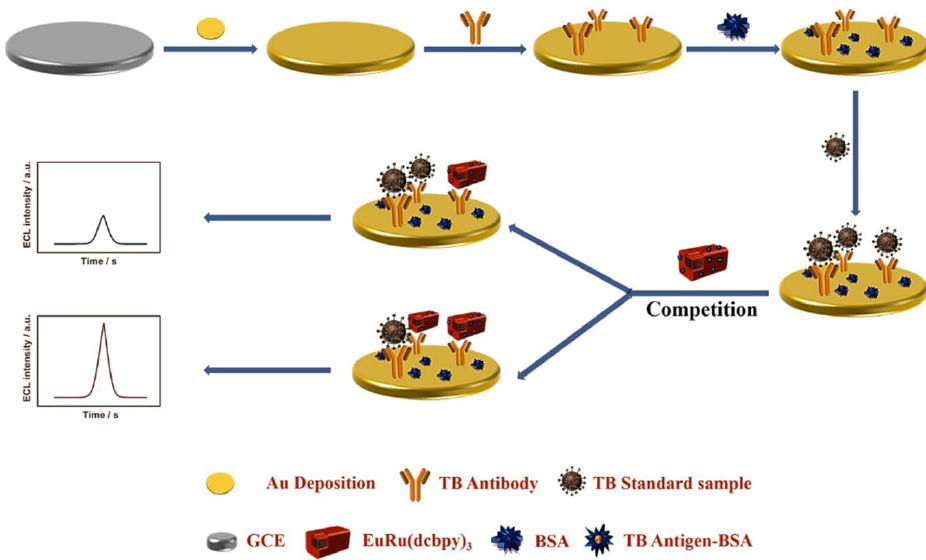
Figure 4. Annihilation luminescent Eu-MOF as a near-infrared electrochemiluminescence probe for trace detection of trenbolone [63] . Copyright © 2022, Elsevier.